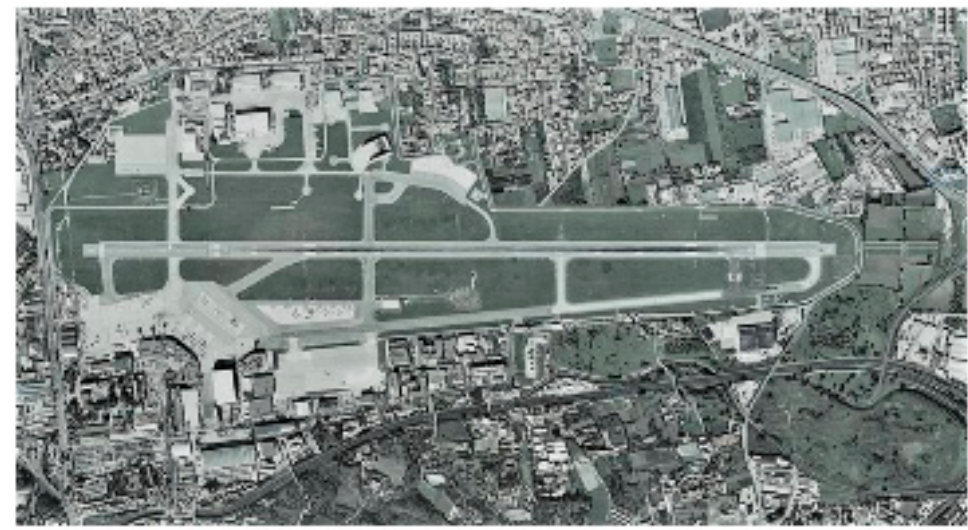
Figure 2. Capodichino Airport (source: www.aeroportodinapoli.it, accessed on 1 March 2021).